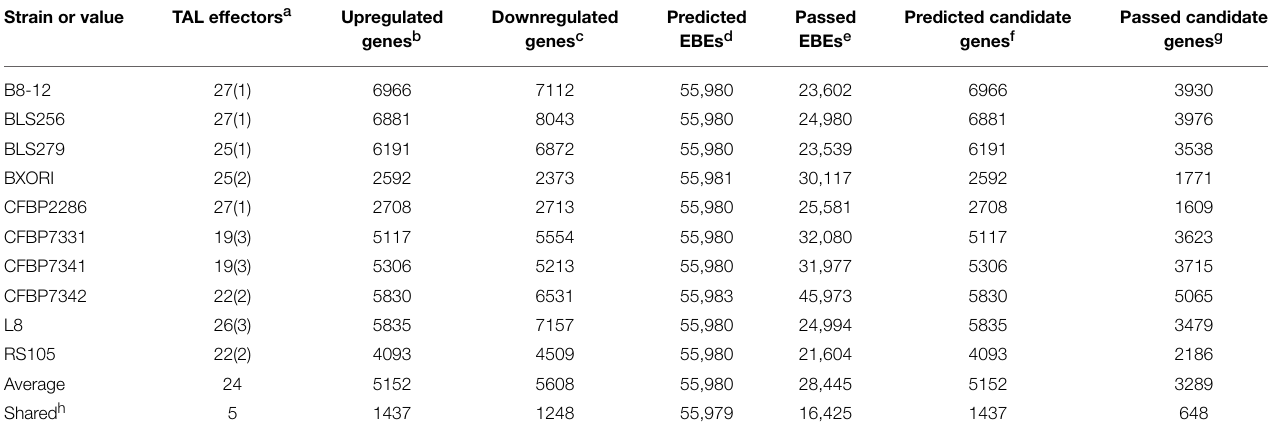
TABLE 2 | Numbers of TAL effectors, induced rice gene expression changes, and target predictions for each Xoc strain. Strain or value TAL effectors a Upregulated Downregulated Predicted Passed Predicted candidate Passed candidate genes b genes c EBEs d EBEs e genes f genes g